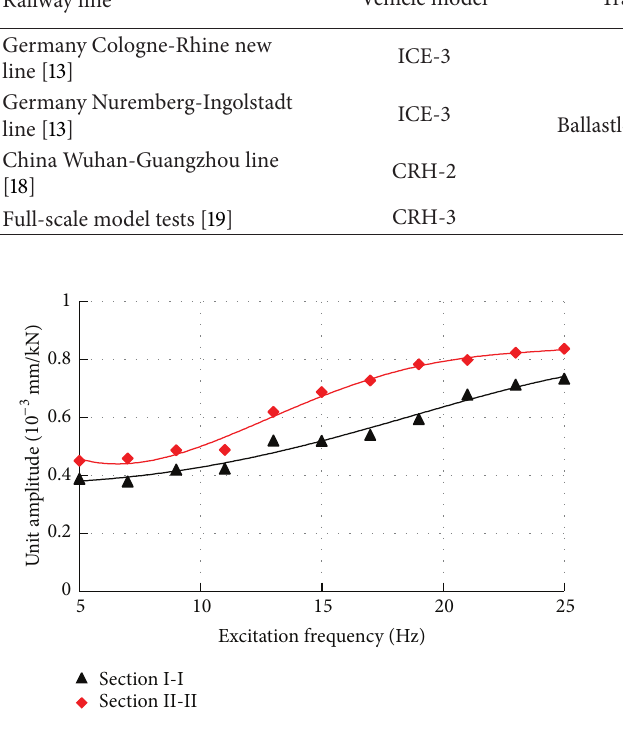
Figure 12: Unit amplitude of the subgrade surface versus vibration frequency.